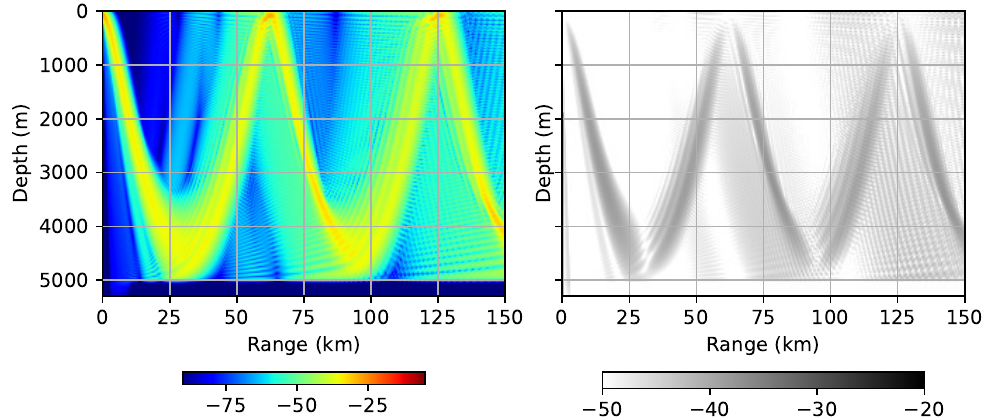
Figure 8. Propagation in the Munk profile. Acoustic pressure distribution (20log | ψ Pade | ) ( left ) and error distribution (10log | ψ Pade − ψ WNI | ) between the Padé and WNI solutions ( right